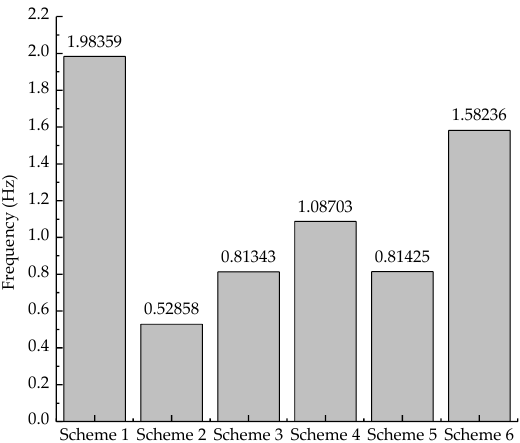
Figure 9. Fundamental frequencies of the bridge in different schemes.